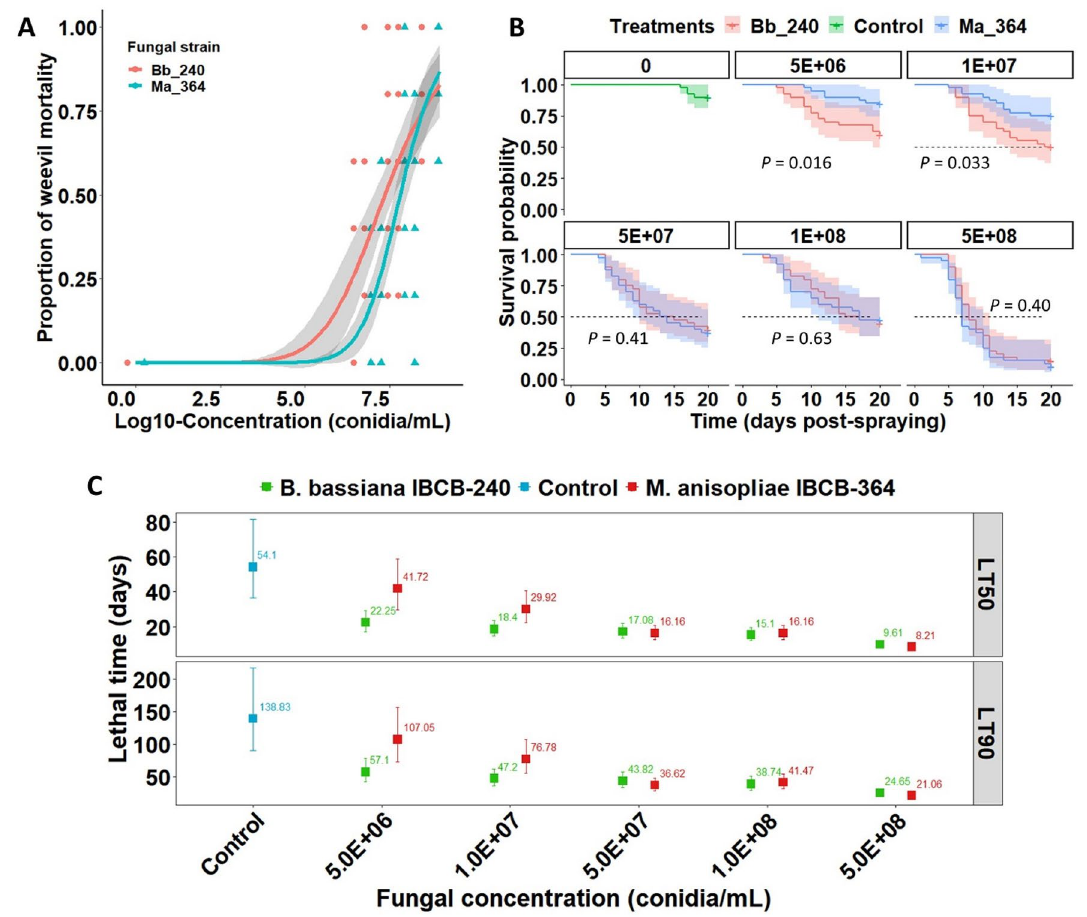
Figure 4. Comparative virulence between strains IBCB-240 ( B. bassiana ) and IBCB-364 ( M. anisopliae ) against G. platensis adults assessed with time-concentration-mortality bioassays. ( A ) Concentration-mortality response curves at 15 days post-spraying fitted with a two-parameter log-logistic models (solid lines are fitted models, grey bands are 95% confidence intervals and points with different shapes are observational data). ( B ) Kaplan– Meier survival curves of G. platensis adults exposed to two fungal strains and compared with log-rank test ( P < 0.05) within each conidial concentration tested. Log-rank P -values for all the pairwise comparisons between survival curves are presented in Table S2. ( C ) Estimated median (LT 50 ) and 90% (LT 90 ) lethal times with their corresponding 95% confidence intervals (whiskers) for G. platensis adults after being sprayed with five conidial concentrations of each fungal strain. Statistical differences between LT 50 or LT 90 values are indicated when their 95% confidence intervals do not overlap.